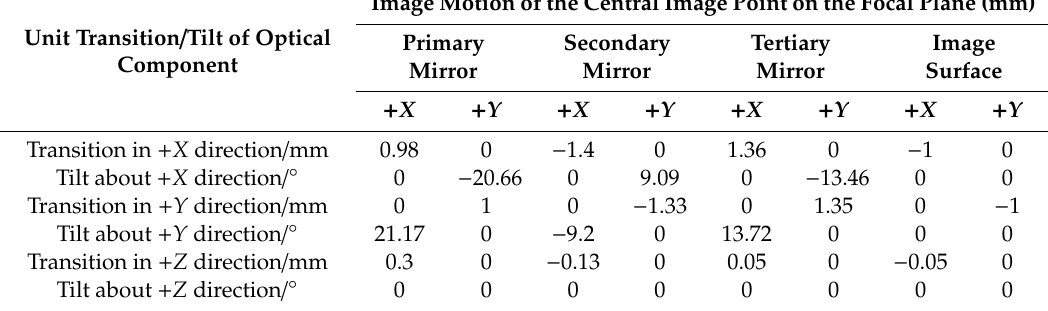
Table 1. The optical amplification factor of each optical component.